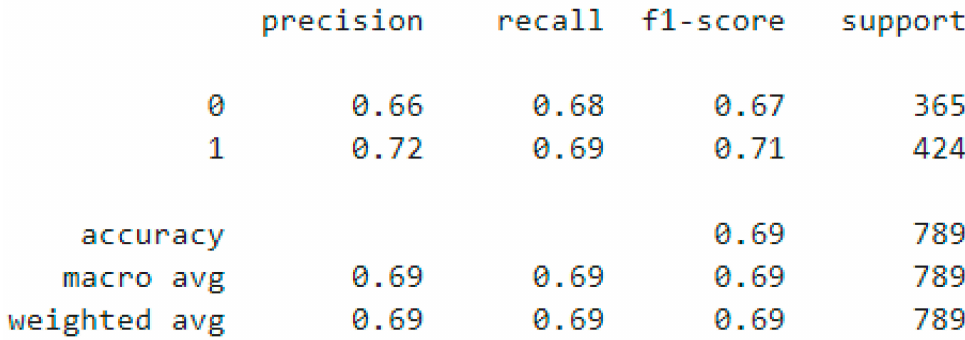
Figure 3. Metrics of the Artificial Neural Network.